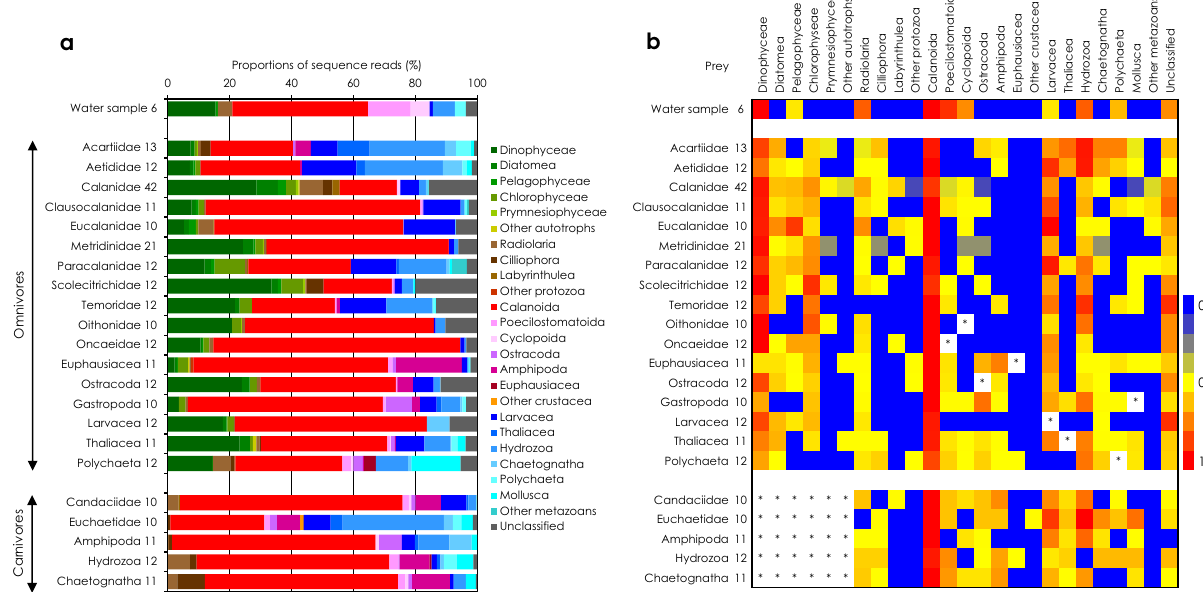
Figure 2. Average proportions for the standardized sequence reads ( a ) and heatmap for average appearance frequency ( b ) of ten dominant prey OTUs from the DNA of ambient water samples (combined) and gut contents of mesozooplankton taxonomic groups in the Kuroshio in the East China Sea and its neighboring waters. Numbers beside group names are the number of replicates. Asterisks indicate eliminated prey Environmental waters. We determined the proportions of SRs for the dominant OTUs in the environ- mental plankton community (i.e., water samples) (Fig. 2a). The proportions of the available prey in water sam- ples were similar among the stations at 50% Bray–Curtis similarity (Supplementary Fig. S2). Calanoids were the most available prey (~ 56%), and poecilostomatoids (~ 26%) or dinoflagellates (~ 29%) were next. On aver- age, copepods comprised 64% of the available prey, whereas contributions of phytoplankton groups (16%) were similar to those of gelatinous organisms (12%) predominantly hydrozoans. The appearance frequencies of the available prey were compared among water samples (Fig. 2b). Dinoflagellates and calanoids were found in all water samples. Radiolarians, poecilostomatoids, cyclopoids and hydrozoans were next most common, showing high appearance frequencies. Higher-taxon-specific prey preferences. The proportions of prey ingested by omnivorous and carnivo- rous mesozooplankton groups were much different than the proportions in water samples (Fig. 2a). However, calanoids predominated in water samples and were always substantial prey for both omnivorous and carnivorous groups. Except for the Acartiidae and Aetididae, the omnivorous copepod families primary ingested calanoids or dinoflagellates. In any case, phytoplankton and copepods comprised more than half of their ingested prey. Phytoplankton prey was more predominant than calanoids among the ingested prey for Calanidae and Scol- ecitrichidae. Acartiid and Aetidid copepods exhibited a preference for gelatinous prey, which represented more than half of their ingested prey, with hydrozoans being predominant. High contributions of gelatinous prey were also found for Paracalanidae (33%) and Temoridae (31%). For the other omnivorous groups, calanoids were the predominant ingested prey. Dinoflagellates were the next most common prey for ostracods, larvaceans and thali- aceans. For carnivorous groups, calanoids comprised 62–72% of the ingested prey, except for the Euchaetidae, which ingested similar amounts of hydrozoans and calanids. Protozoans and amphipods accounted for large proportions of the prey ingested by gelatinous carnivores. For omnivorous mesozooplankton groups, appearance frequencies were high for dinoflagellates and cala- noids, and corresponded to the prey availability in water samples (Fig. 2b). The most frequently appearing prey was calanoids for all omnivorous groups. Dinoflagellates were a common prey taxon, with a high appearance frequency for copepods. Besides these frequently appearing prey, chlorophytes and gelatinous prey represented by larvaceans and hydrozoans appeared frequently in the gut contents of omnivorous mesozooplankton groups, whereas chlorophytes were rare in water samples. For carnivorous groups, the most frequently appearing prey was calanoids. The next most frequent prey taxa were larvaceans and hydrozoans, and carnivorous groups ingested other minor prey in water samples, such as amphipods and poecilostomatoids. Species-specific preferences. Prey preference generally differed among congeneric or intergeneric spe- cies. The proportions of the dominant prey for omnivorous and carnivorous mesozooplankton species were much different than the proportions in water samples (Fig. 3a). As in comparisons among higher taxonomic groups, calanoids predominated in water samples and often contributed substantially to the ingested prey for both omnivorous and carnivorous species. Besides the predominant prey, there were species-specific propor-